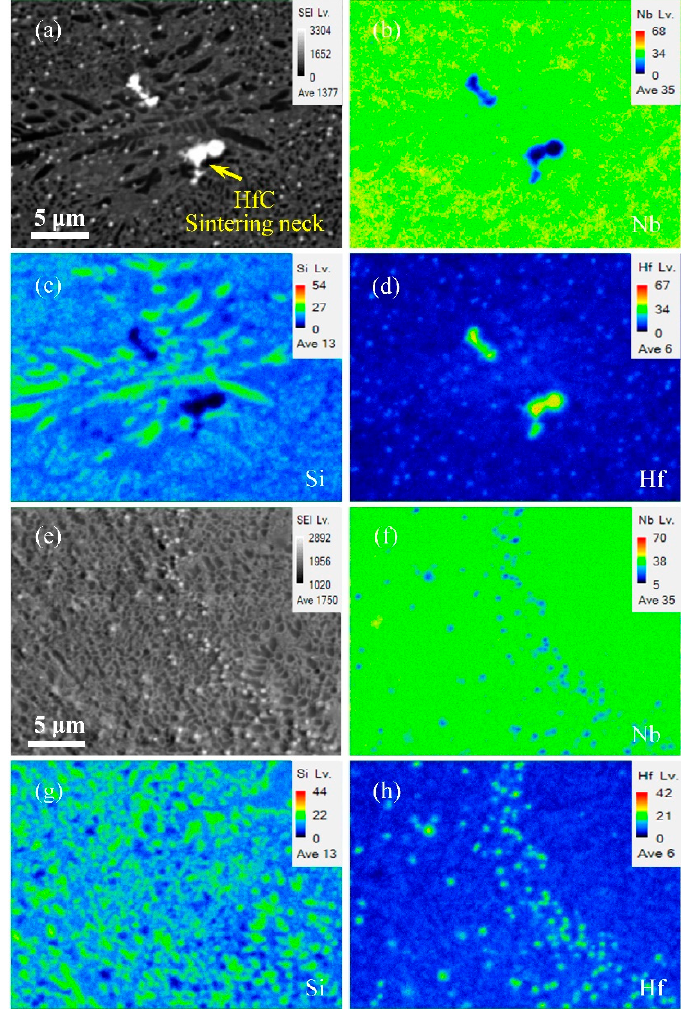
Figure 4. Results of the EPMA experiments. ( a ) BSE image showing the location of the EPMA maps at scanning speed 600 mm/s; ( b – d ) the corresponding elemental concentration distribution mappings of Nb, Si and Hf; ( e ) BSE image showing the location of the EPMA maps at scanning speed 1000 mm/s; ( f – h ) the corresponding elemental concentration distribution mappings of Nb, Si, and Hf.